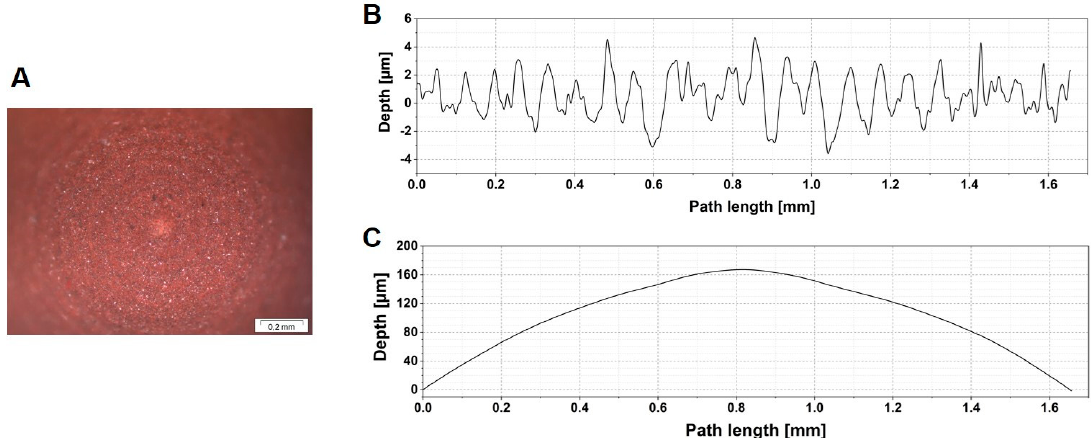
Figure 1. ( A ) Micrograph of FKM hemispherical sample texture ( B ) Roughness and ( C ) waviness of the topography of FKM probe surface.